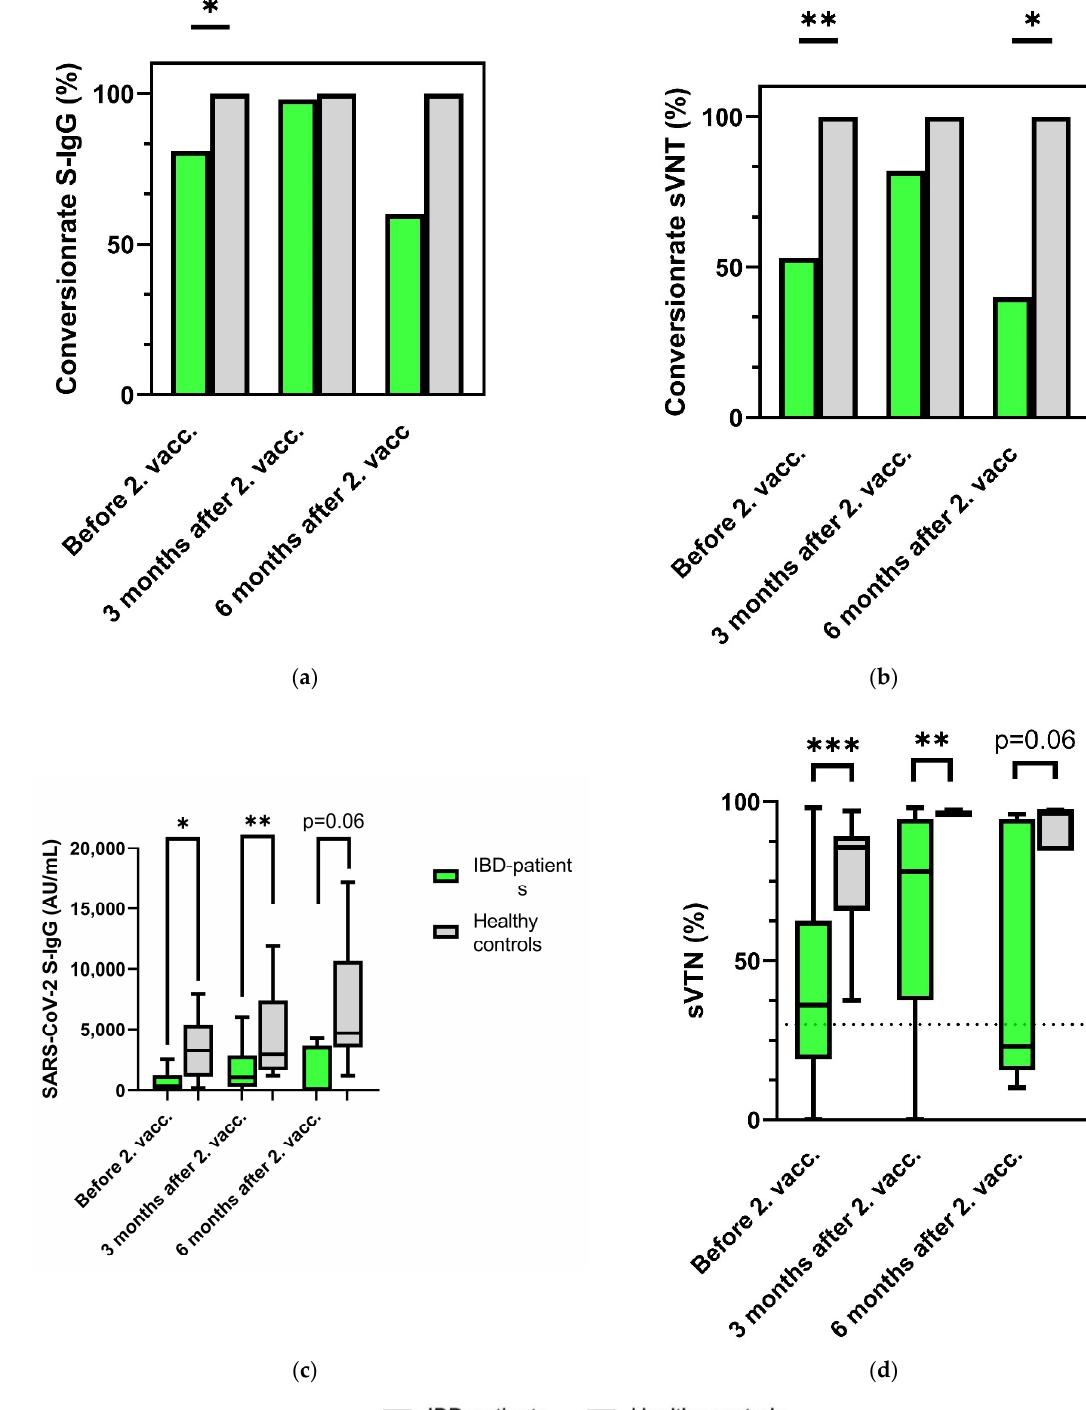
Figure 3. Humoral response of IBD patients and healthy controls before second vaccination, as well as 3 and 6 months after second vaccination. ( a ) Percentage seroconversion rates (sVTN > 30%); ( b ) percentage seroconversion rates (SARS-CoV-2 S-IgG ≥50 AU/mL); ( c ) quantitative detection of SARS-CoV-2 S-IgG; ( d ) percentage sVTN inhibition, representation of the cutoff values (30% inhibi- tion) as a dashed line. IBD: inflammatory bowel disease; vacc: vaccination. Tukey boxplots, * p < 0.05, ** p < 0.01, and *** p <